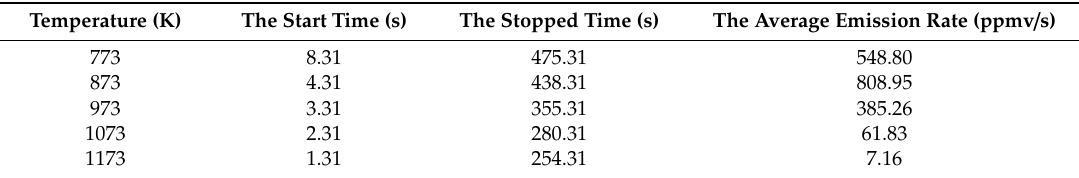
Table 2. The effect of combustion temperature on CO emission.